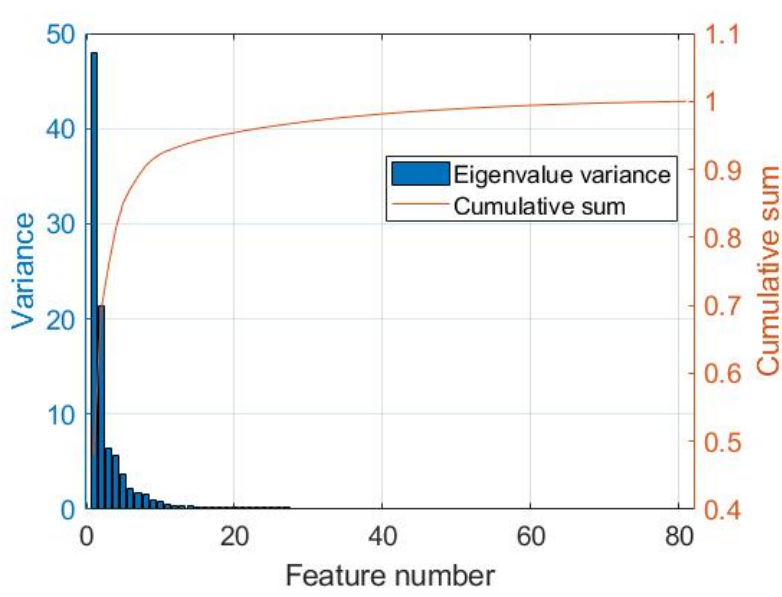
Figure 21. Variance associated with each feature after PCA on the localization dataset.